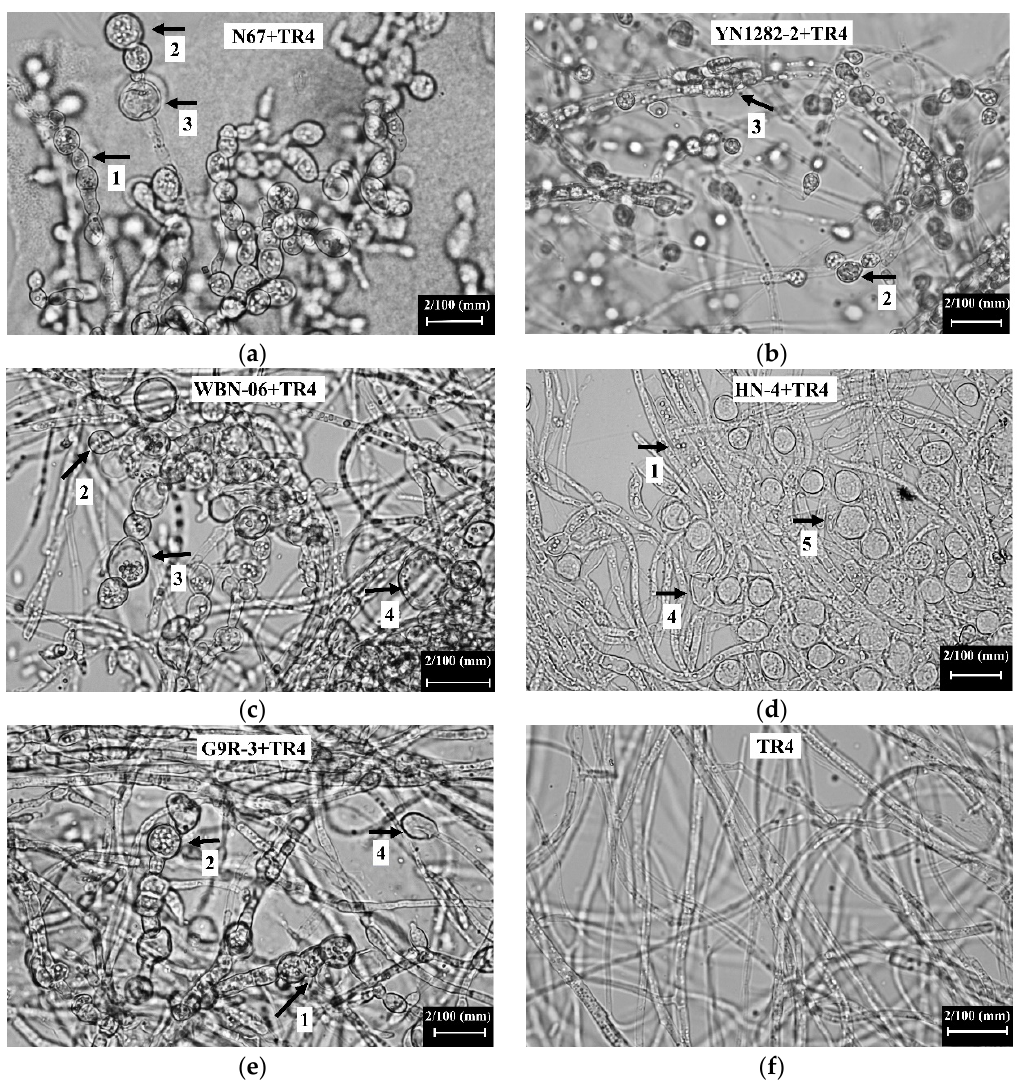
Figure 3. Observation of TR4 mycelial morphology in dual-culture test of N67, YN1282-2, WBN06, HN04, G9R-3 ( a – e ) and single-cultured TR4 ( f ) at 7 days. The white text box at the top of each picture corresponds to the mycelial morphology of TR4 when each strain was dual-cultured with TR4 for 7 days (corresponding to Figure 3( a – e )). The arrows with different labels indicate various abnormal manifestations of TR4 mycelium morphology. Arrow 1: The TR4 hyphae expanded, and the internodes shortened. Arrow 2: The top of TR4 hyphae expanded. Arrow 3: The TR4 hyphae expanded in the middle. Arrow 4: The TR4 hyphae forms vesicles. Arrow 5: The TR4 hyphae forms chlamydospores.